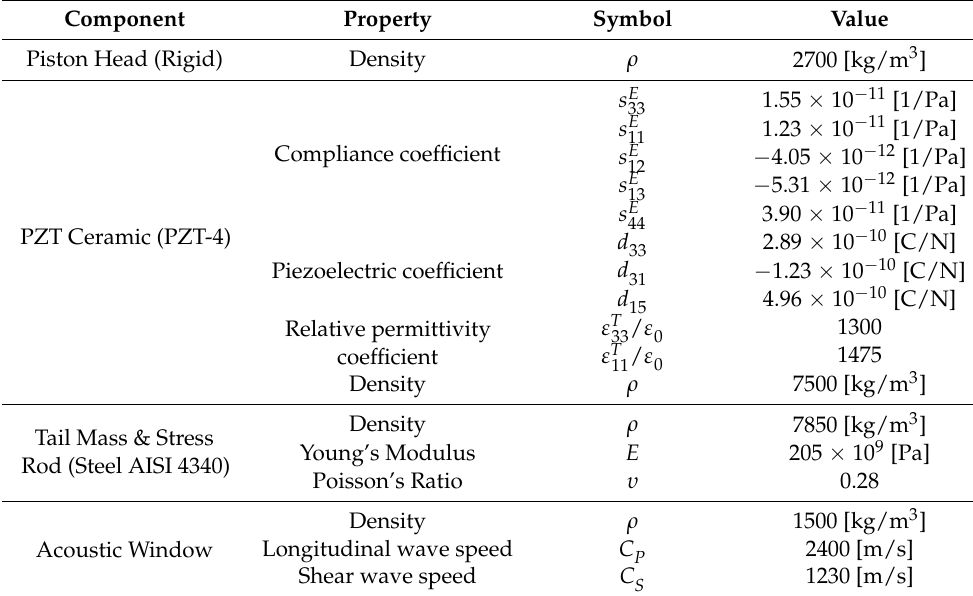
Figure 5. Tonpilz transducer: ( a ) Geometry. ( b ) FE Model. Table 1. Material properties of the analysis